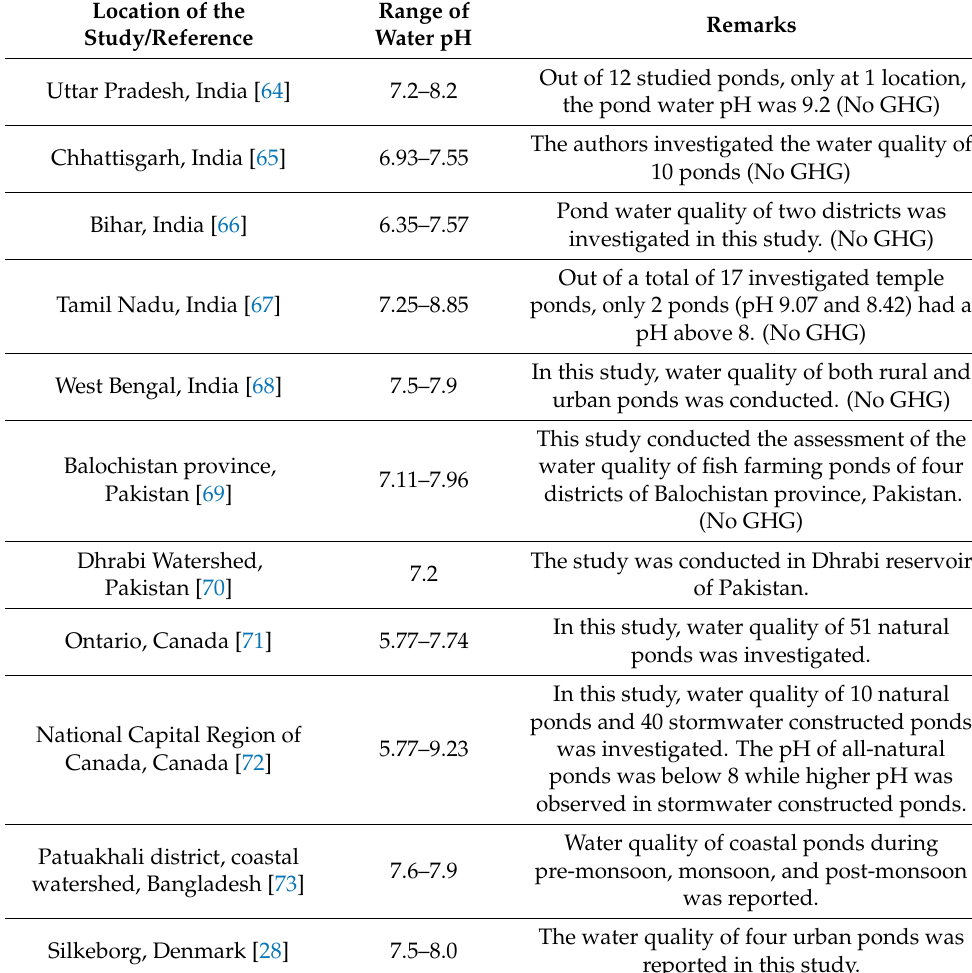
Table 3. pH range of the water bodies at the global